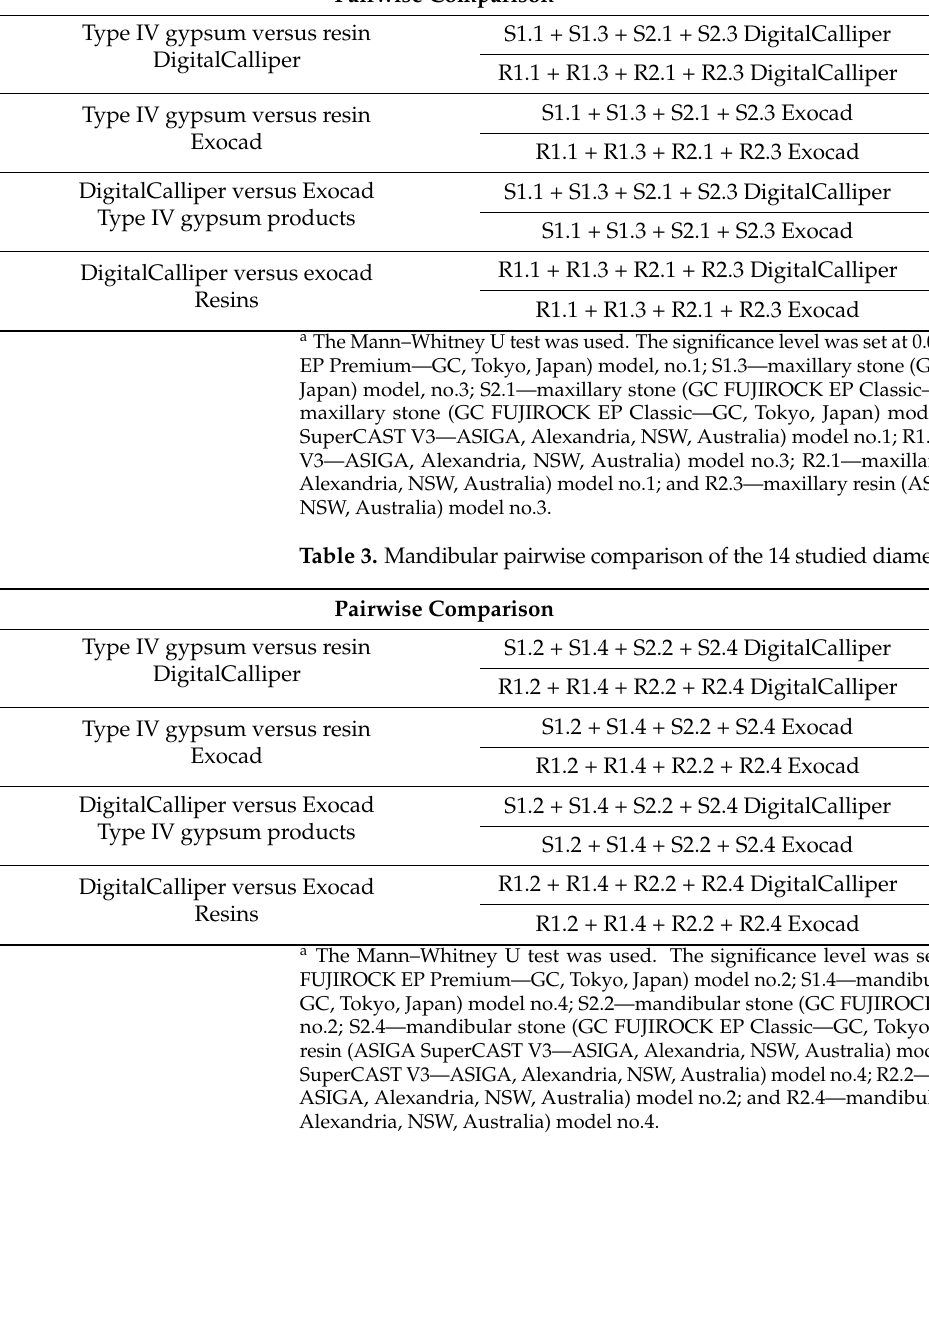
Table 2. Maxillary pairwise comparison of the 14 studied diameters using the Mann–Whitney U test. Pairwise Comparison Mean Rank p -Value a